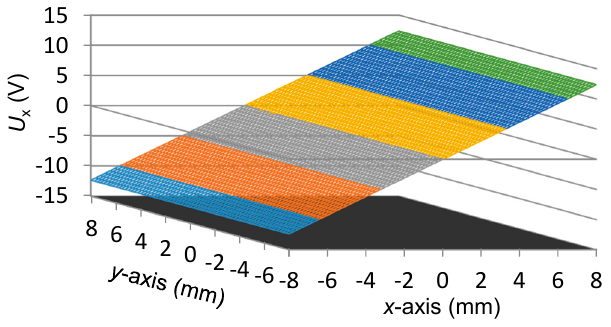
Figure 6. Scanning result of U x .